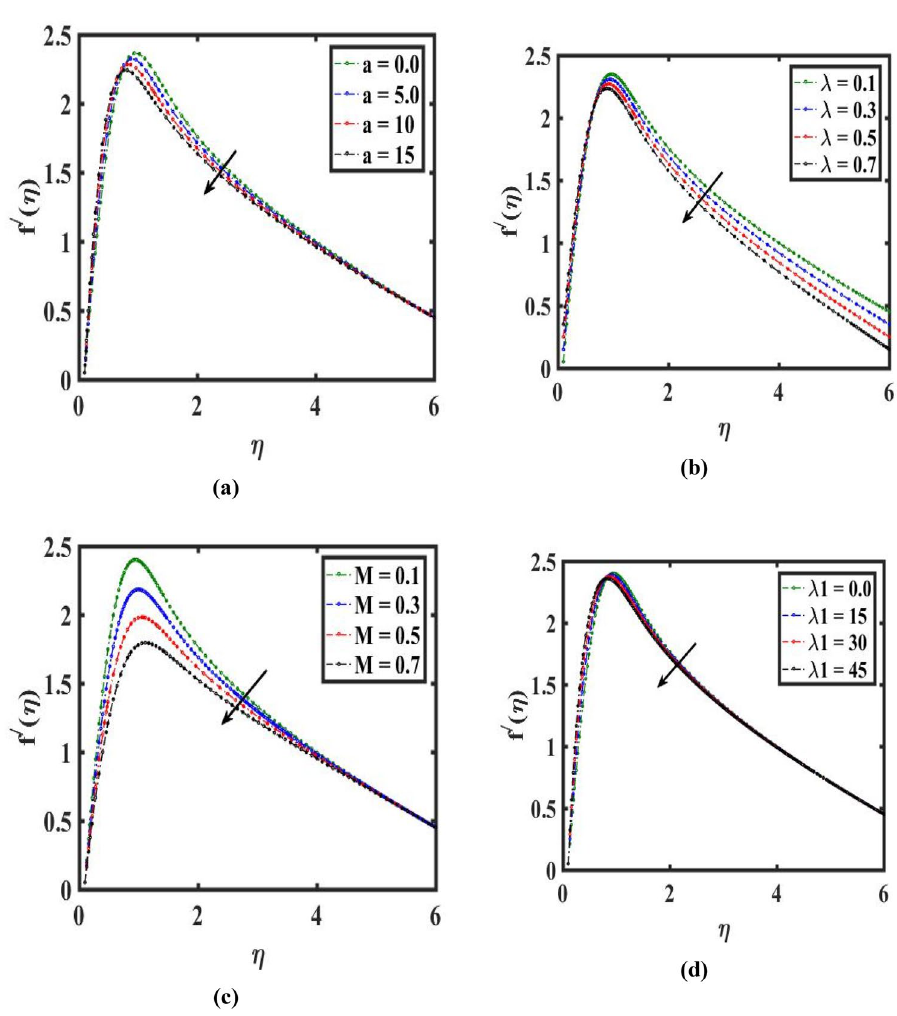
Figure 3. Variation of needle thickness a , velocity ratio (cid:31) , Hartmann number M , and mixed convection (cid:31) 1 on velocity f ′ (η)